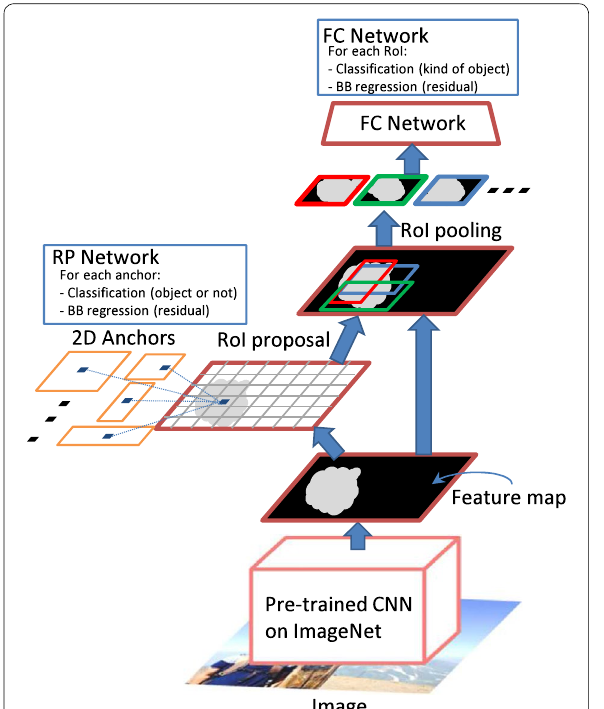
Fig. 4 Diagram of architecture of Faster R-CNN